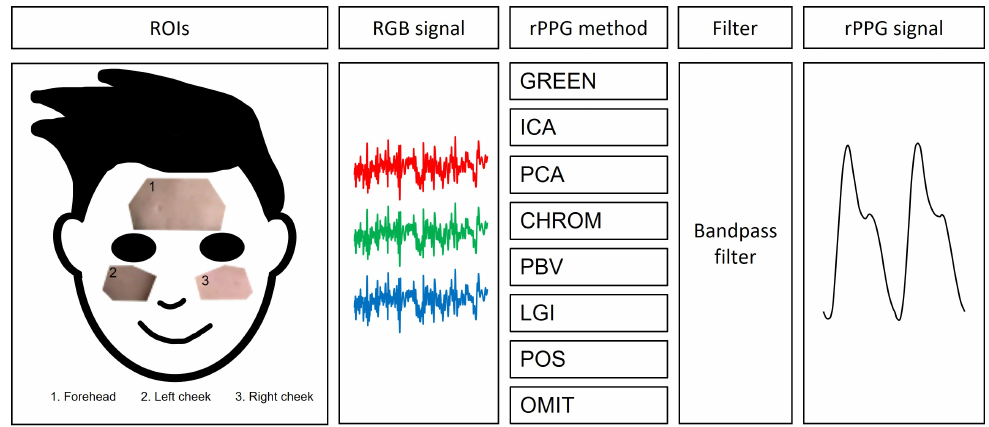
Figure 1. Graphical representation of the pipeline from a selfie video to an rPPG signal. Note that ROIs = region of interest, RGB signal = time series of average color channel value, rPPG method = method from the RGB signal to the rPPG